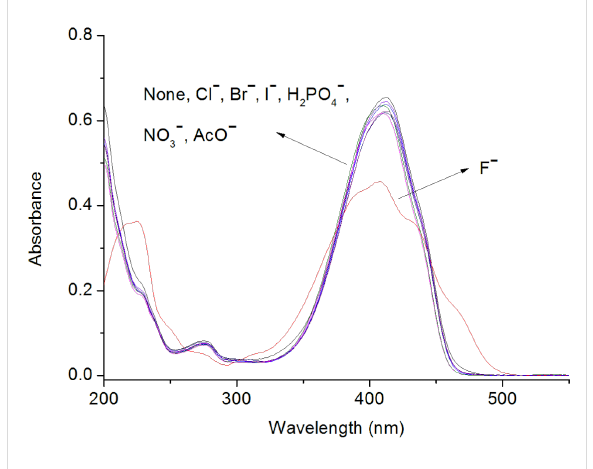
Figure 1: Spectral changes of BIP (4 × 10 − 5 M) in CH 3 CN after the ad- dition of 50 equiv of anions (as their tetrabutylammonium salts).